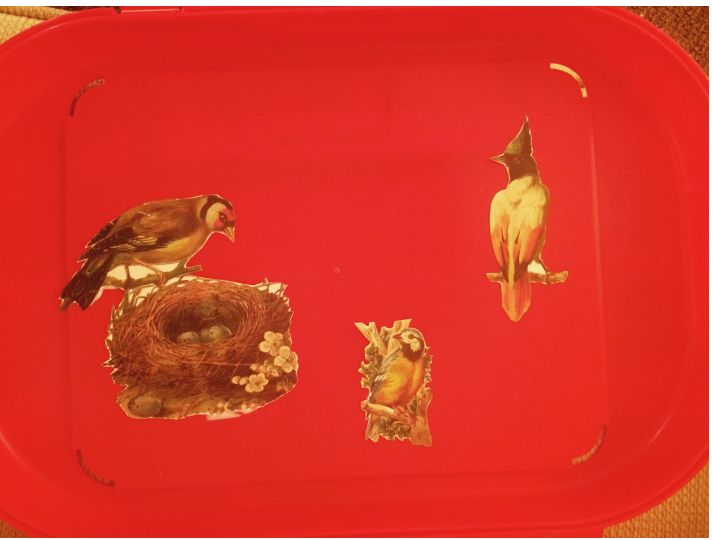
Figure 9Figure 9. Birds and nests I carry with me/Transitional object. Plastic container, collage and